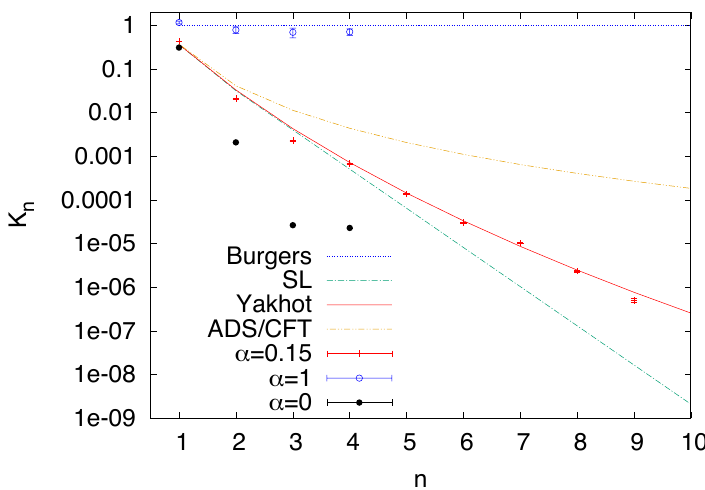
Figure 26. Semi-logarithmic plot of reduced Kramers–Moyal coefficients from DNS of the generalized Burgers Equation (26). The coefficients for Burgers turbulence ( α = 1) are in the range of 1 which agrees with the phenomenological predictions. The semi-logarithmic plot reveals that the reduced Kramers–Moyal coefficients for the intermediate case ( α = 0.15) follow Yakhot’s mean field theory (v.) . Note that higher-order n > 5 coefficients for the Burgers and the purely nonlocal case ( α = 0) could not be accurately obtained due to poor polynomial fits (Burgers case) or considerable deviations from Equation (17) (nonlocal